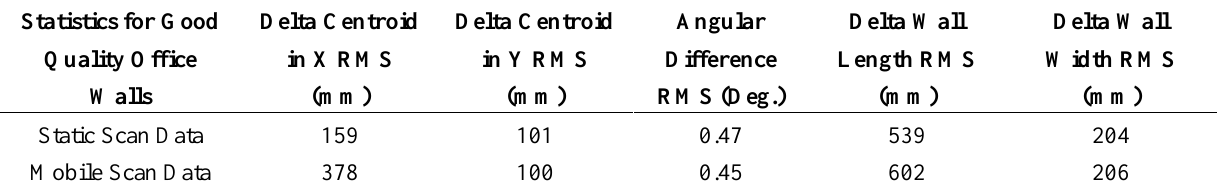
Figure 12. Charts of calculated reconstruction quality for each wall in the reference human-created model of the office against the automated geometry from the two scan datasets. Table 3. Statistics for the accuracy of three of the main four bounding office walls from both datasets (walls 3, 5 and 6) against the reference model; wall 4 is ignored for the gross error from the mobile data detection as seen in Figure